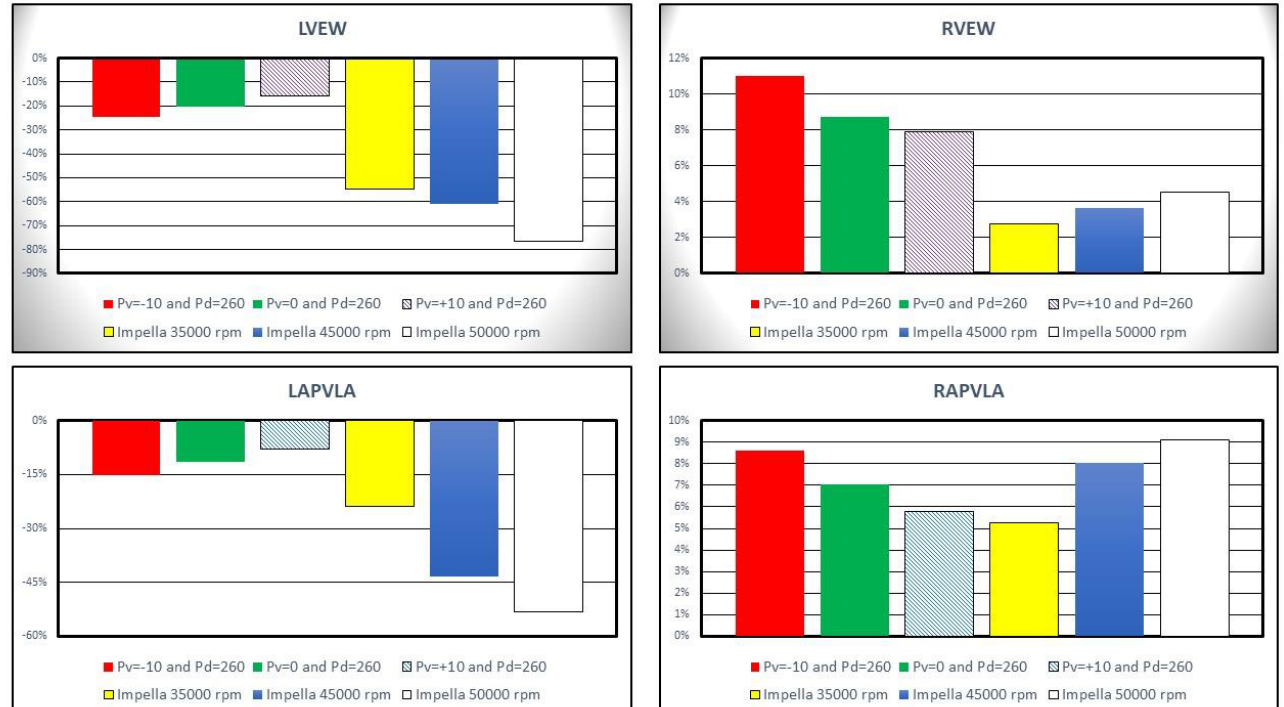
Figure 8. Percentage change calculated in comparison to baseline conditions for left ventricular external work (top left panel), right ventricular external work (top right panel) and left and right atrial pressure – volume loop area (bottom left and right panels). The above values were obtained when the Impella rotational speed was set to 35,000, 45,000 and 50,000 rpm. During the simulations with IABP support the driving and vacuum pressures were set to Pd = 260 mmHg and to Pv = −10, Pv = 0 and Pv = +10 mmHg, respectively.